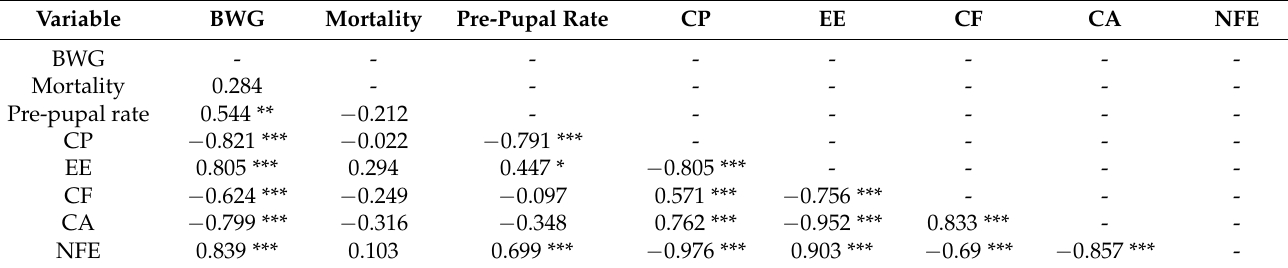
Table 4. Spearman’s correlations in Experiment 1.